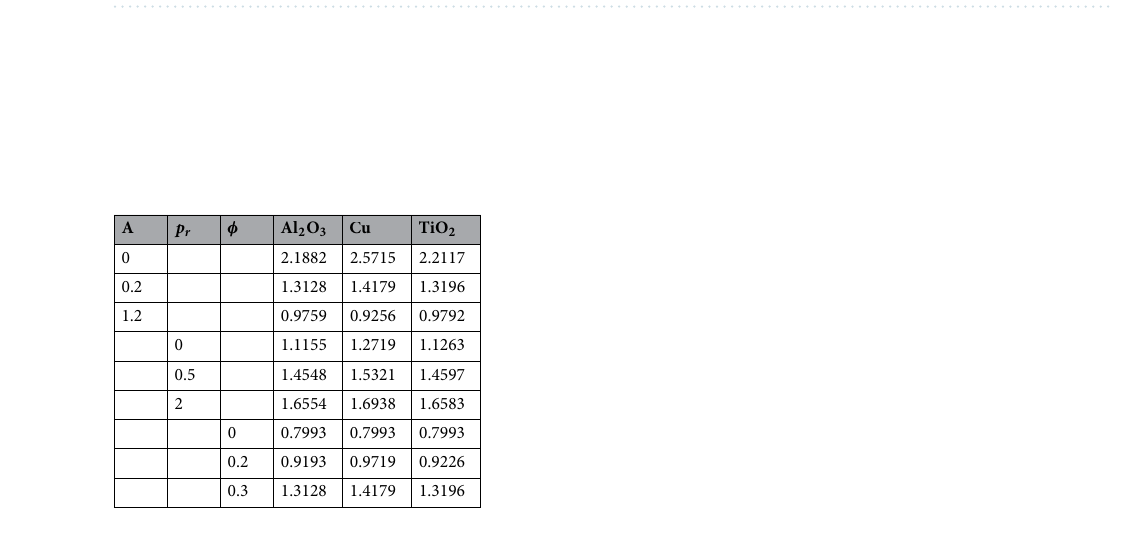
Figure 17. Streamlines for numerous values of φ .